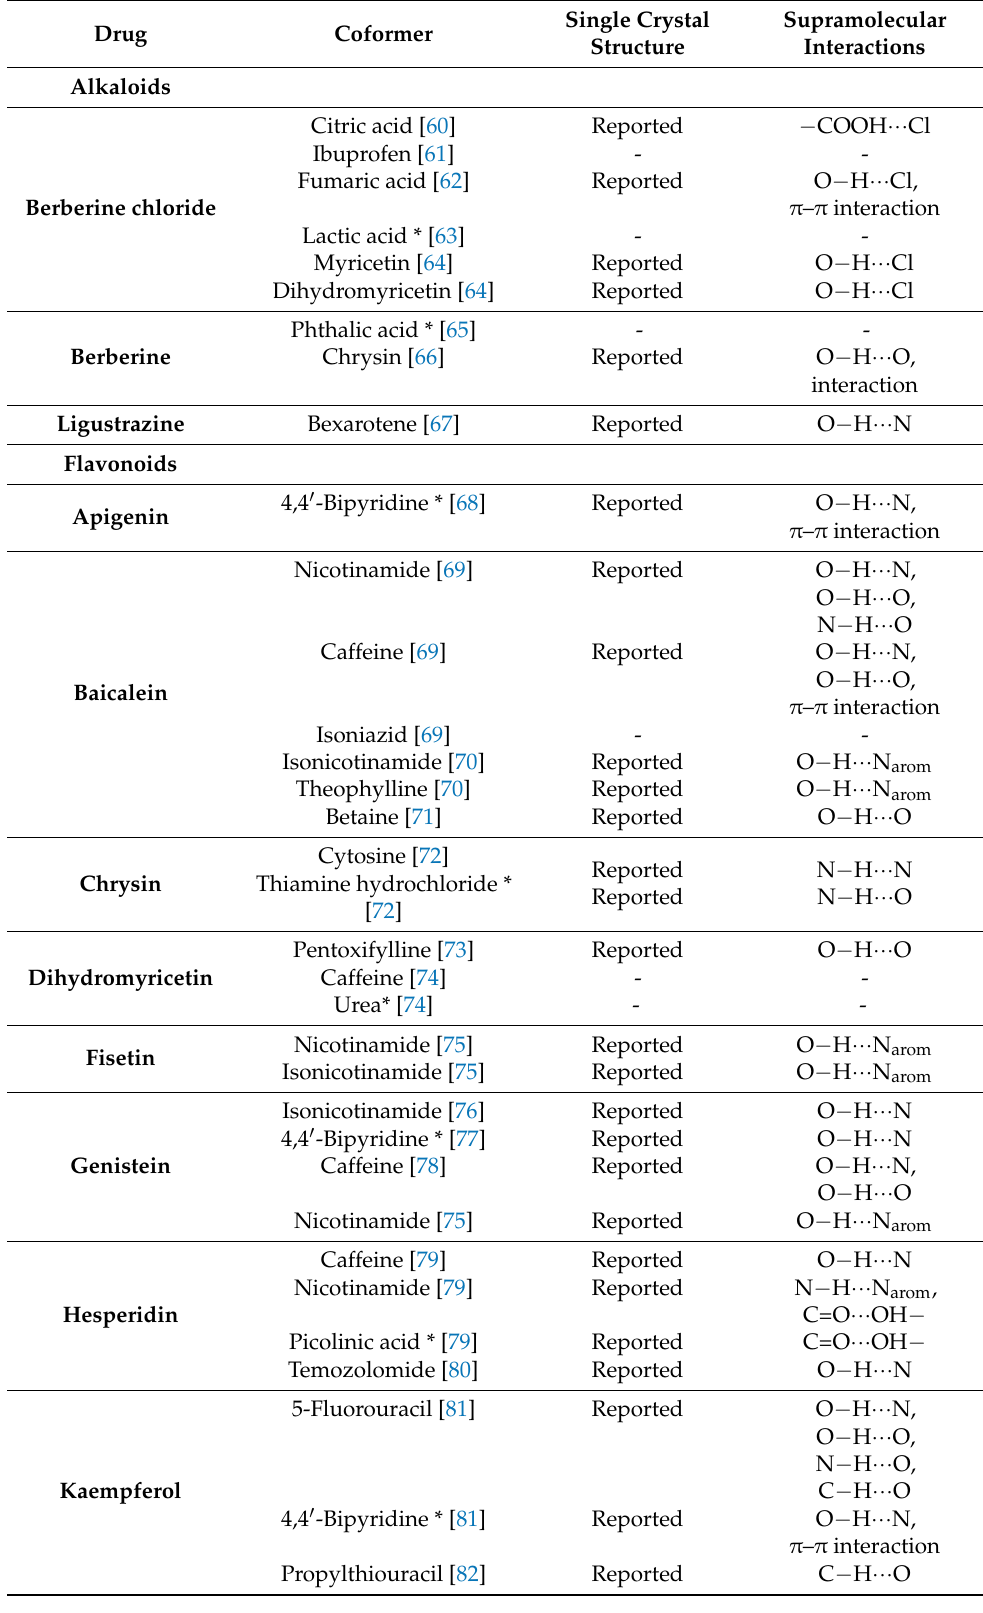
Table 3. Supramolecular interactions formed in the reported